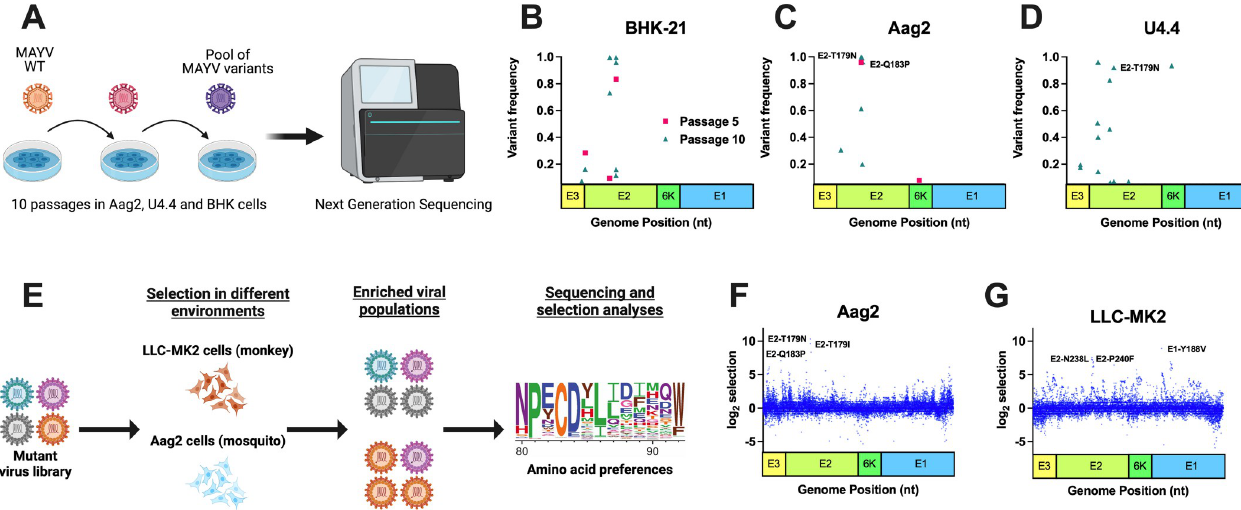
Fig 1. Natural evolution and deep mutational scanning (DMS) enrich for similar high frequency mutations in Mayaro virus (MAYV). Experimental evolution was performed using traditional serial passaging and DMS to identify molecular determinants of emergence. A: Traditional experimental evolution was performed by serially passaging MAYV at a MOI of 0.01 in BHK-21 cells (hamster) and two insect cell lines, Aag2 ( Ae . aegypti ) and U4.4 ( Ae . albopictus ). A total of ten passages were performed. B-D: Following one, five, and ten passages, the viral RNA was sequenced using Illumina NGS to identify potentially adaptive mutations. No high frequency variants were identified following passage one, and as such are not depicted here. E: The three MAYV DMS populations, along with WT MAYV, were used to perform three passages in Aag2 ( F ) and LLC-MK2 ( G ) cells. Following passage, the viral RNA was sequenced, and selection analyses were performed to identify enriched variants. The top three variants in each environment, based on selection strength, are presented for each graph. A and E were created with BioRender.com whose terms and conditions are at biorender.com/terms.